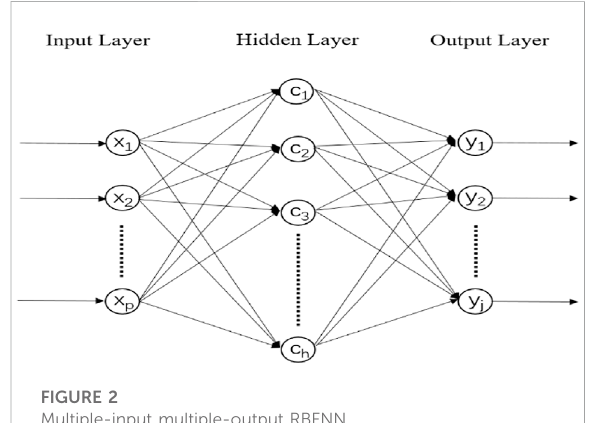
FIGURE 2 Multiple-input multiple-output